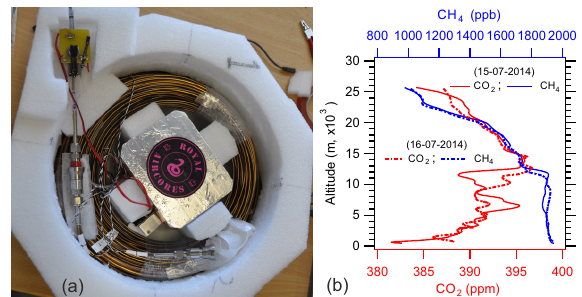
Figure 1. (a) Picture of an AirCore, used during the sampling cam- paign at Sodankylä, constructed from long thin walled stainless steel tubing ( ≈ 100m long, wall thickness of 0.254mm). (b) Cor- rected vertical concentration profiles of CO 2 (red) and CH 4 (blue) retrieved through AirCore samplings performed on 15 July 2014 (solid line) and 16 July 2014 (dashed line) at Sodankylä. Note the different scale span for CO 2 and CH 4